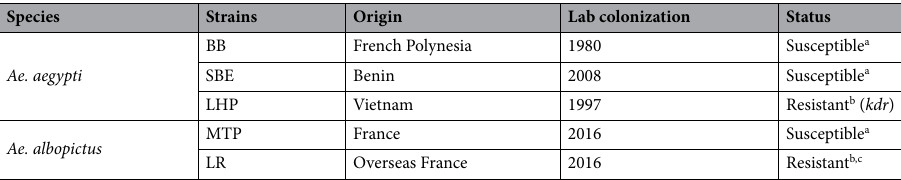
Table 3. Aedes albopictus and Ae. aegypti mosquitoes strains. BB Bora Bora, SBE Bénin, LHP Long-Hoà, MTP Montpellier, LR La Réunion. a Susceptible to all insecticides class. b Resistant to pyrethroids, the main insecticide class used for Aedes vector control, kdr: knockdown resistance. c The characterization of molecular and metabolic mechanisms of insecticide resistance is